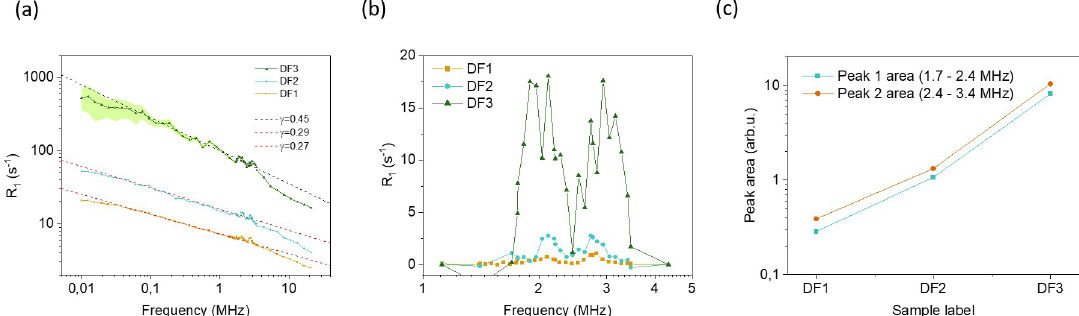
Fig 6. a) 1 H spin-lattice relaxation profiles (dispersion curves) of the cartilage sample measured at different hydration values, DF1-3, showing the variation in R 1 values as a function of Larmor frequency as well as the standard deviations that are becoming visible only in the dry sample. Best fits to the lower-frequency power-law exponents are indicated by dashed lines. b) The quadrupolar peaks isolated from the dispersion profiles, with the baseline subtracted. c) The area of the quadrupolar peaks showing a larger increase as the sample becomes less hydrated and the influence of the solid matrix